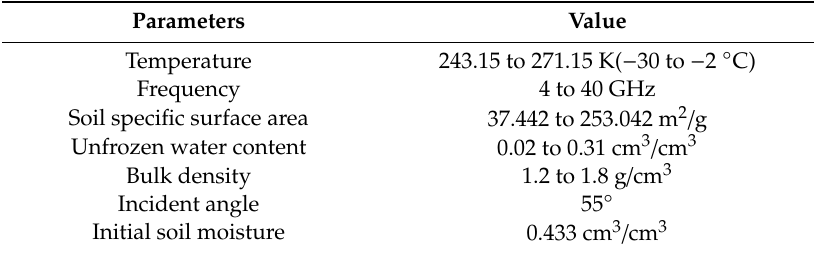
Table 1. Setup of the key parameters in the simulation